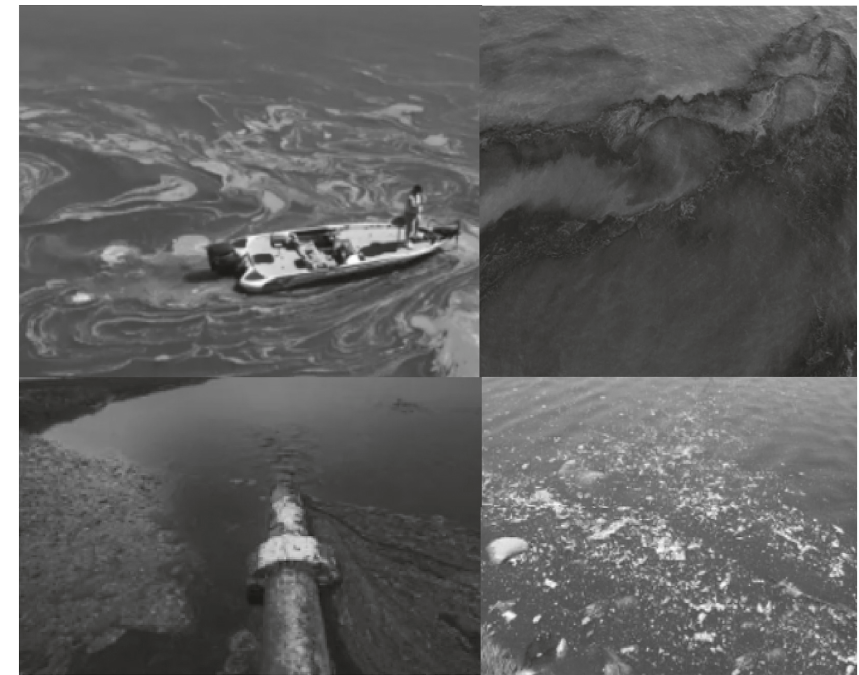
Figure 1: Water pollution from organic pollutants.